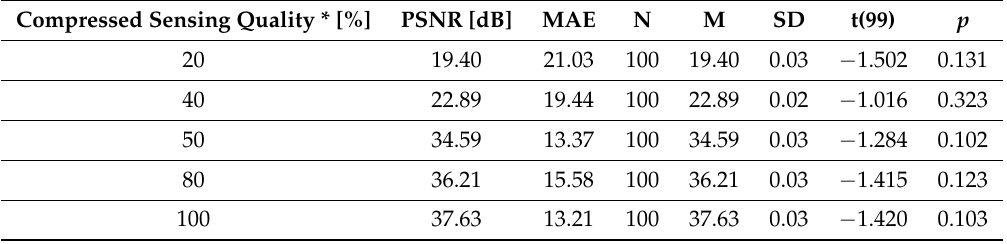
Table 10. The performance of the presented algorithm for the data from Figure 9 at different Compressed Sensing quality ratios.